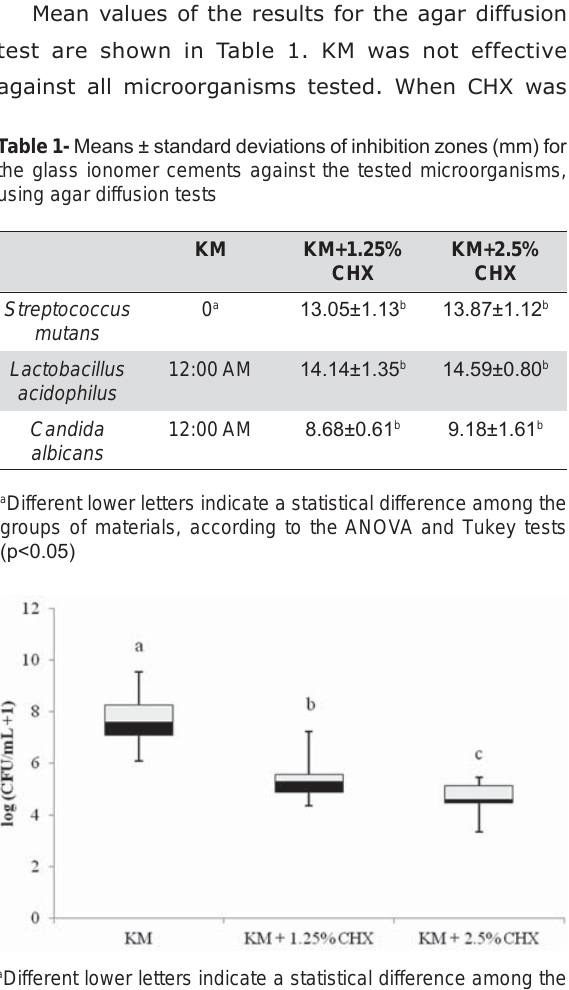
Figure 2- Means (standard deviations) of the percentage of odontoblast-like cell viability after exposure to extracts obtained